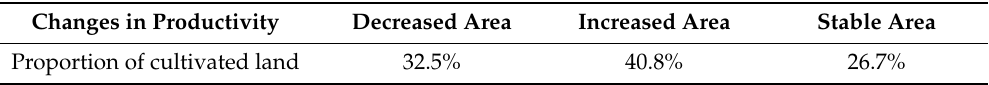
Figure 12. Slope, p, productivity changes, and potential space of the second crop MAD during a double season. ( a ) the slope of the linear regression equation; ( b ) the significance of the productivity changes ( p < 0.05); ( c ) the productivity changes in the second crop; ( d , e ) the potential space of the second crop in the area with significant changes in productivity. Table 5. Changes in cultivated land productivity in the second crop of a double